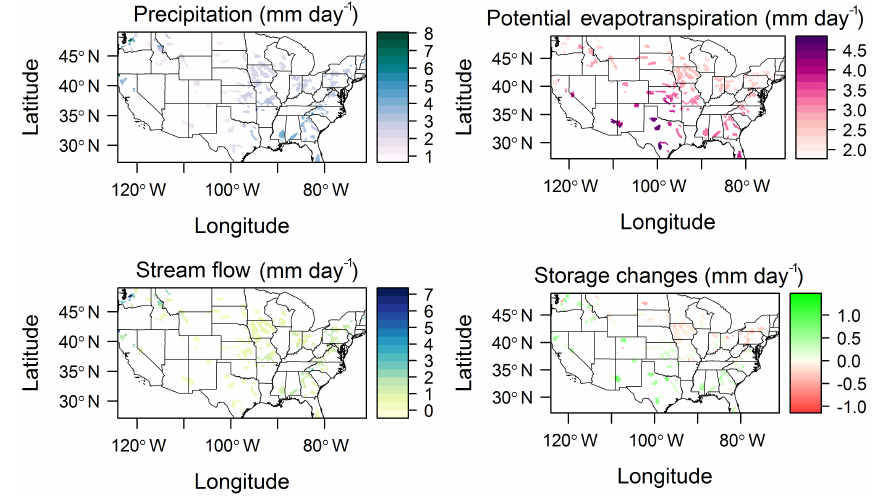
Figure 1. Mean of annual precipitation, potential evapotranspiration, streamflow, and storage changes in millimeters per day from 1983 to